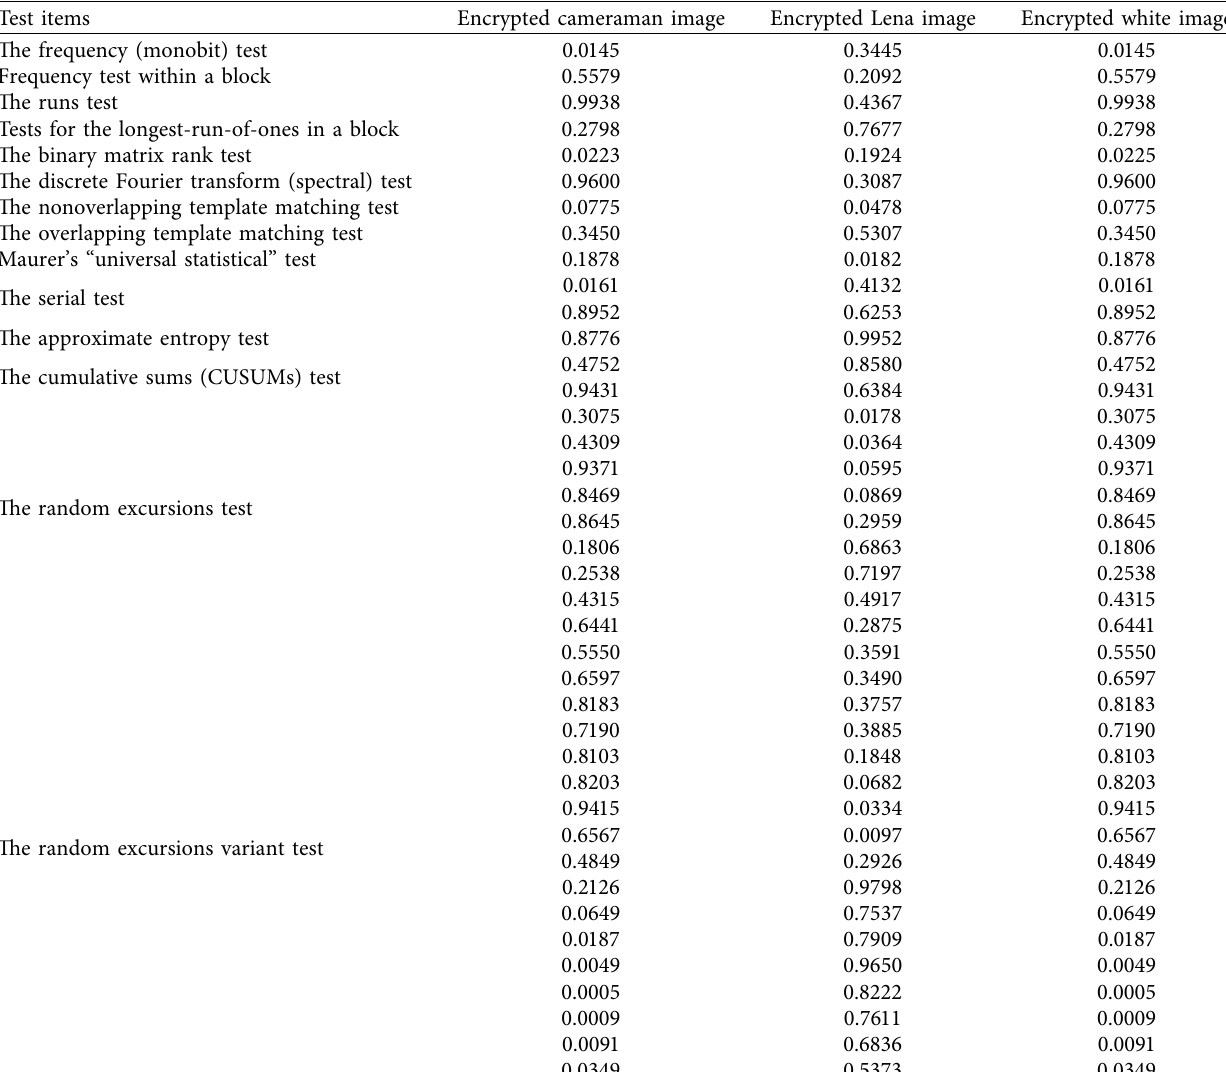
Table 12: Cipher randomness test.